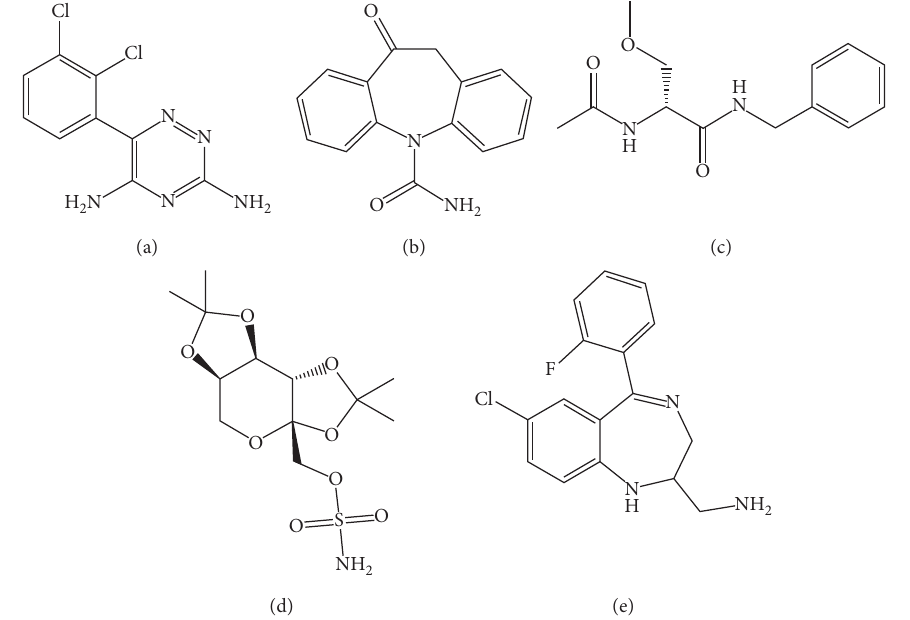
Figure 1: Chemical structure of lamotrigine (a), oxcarbazepine (b), lacosamide (c), topiramate (d), and internal standard (e).